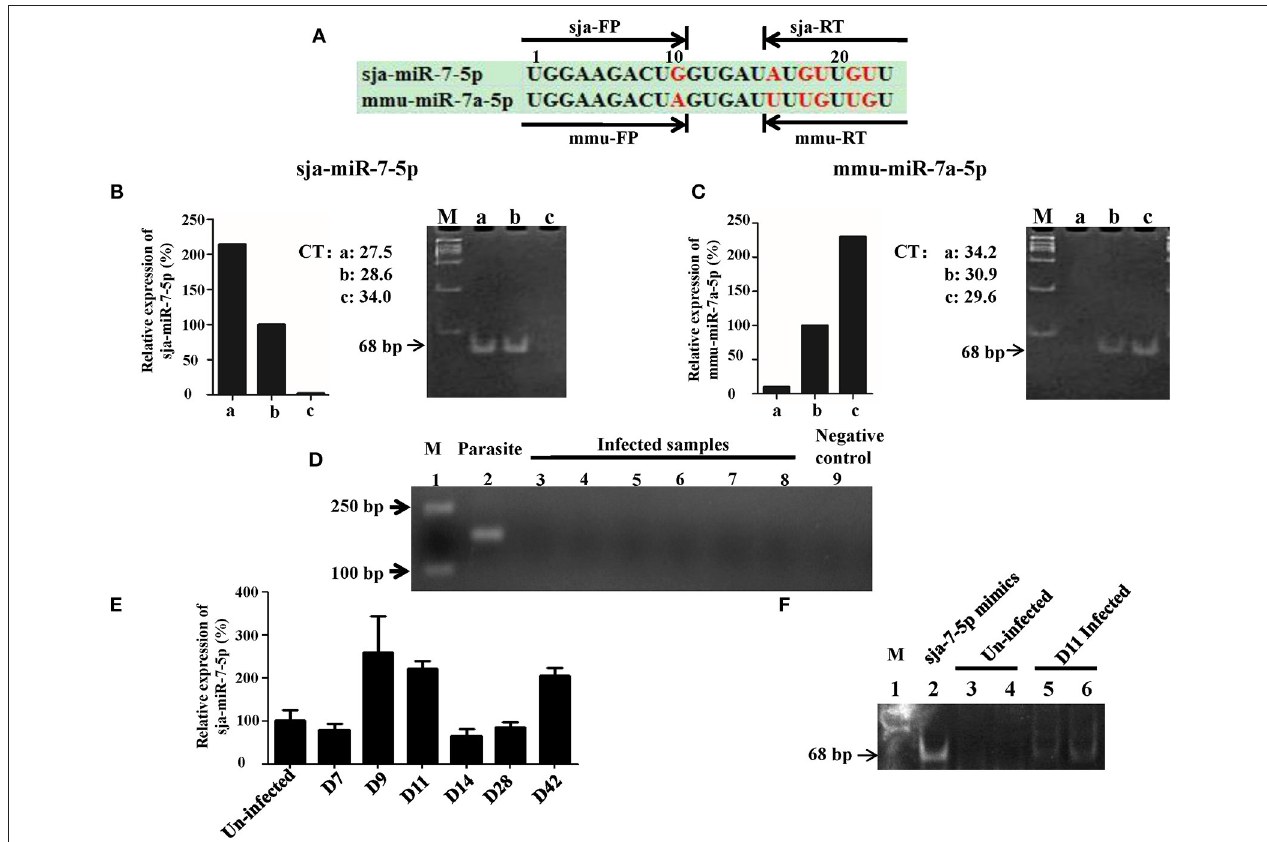
FIGURE 1 | Detection of sja-miR-7-5p in infected hepatocytes . (A) A schematic diagram represents two sets of primers of reverse transcription stem-loop primer (RT) and forward primer (FP) for sja-miR-7-5p or mmu-miR-7a-5p, respectively. (B,C) Preparation of RNA samples: a. 200 ng Schistosoma japonicum egg RNA; b. mixture of equal amount of Schistosoma japonicum egg RNA (100 ng) and Hepa1-6 cell RNA (100 ng); c. 200 ng Hepa1-6 cell RNA. The three RNA templates were transcribed into cDNA using the corresponding reverse transcription stem-loop primer, respectively, which were used for qRT-PCR by the corresponding forward